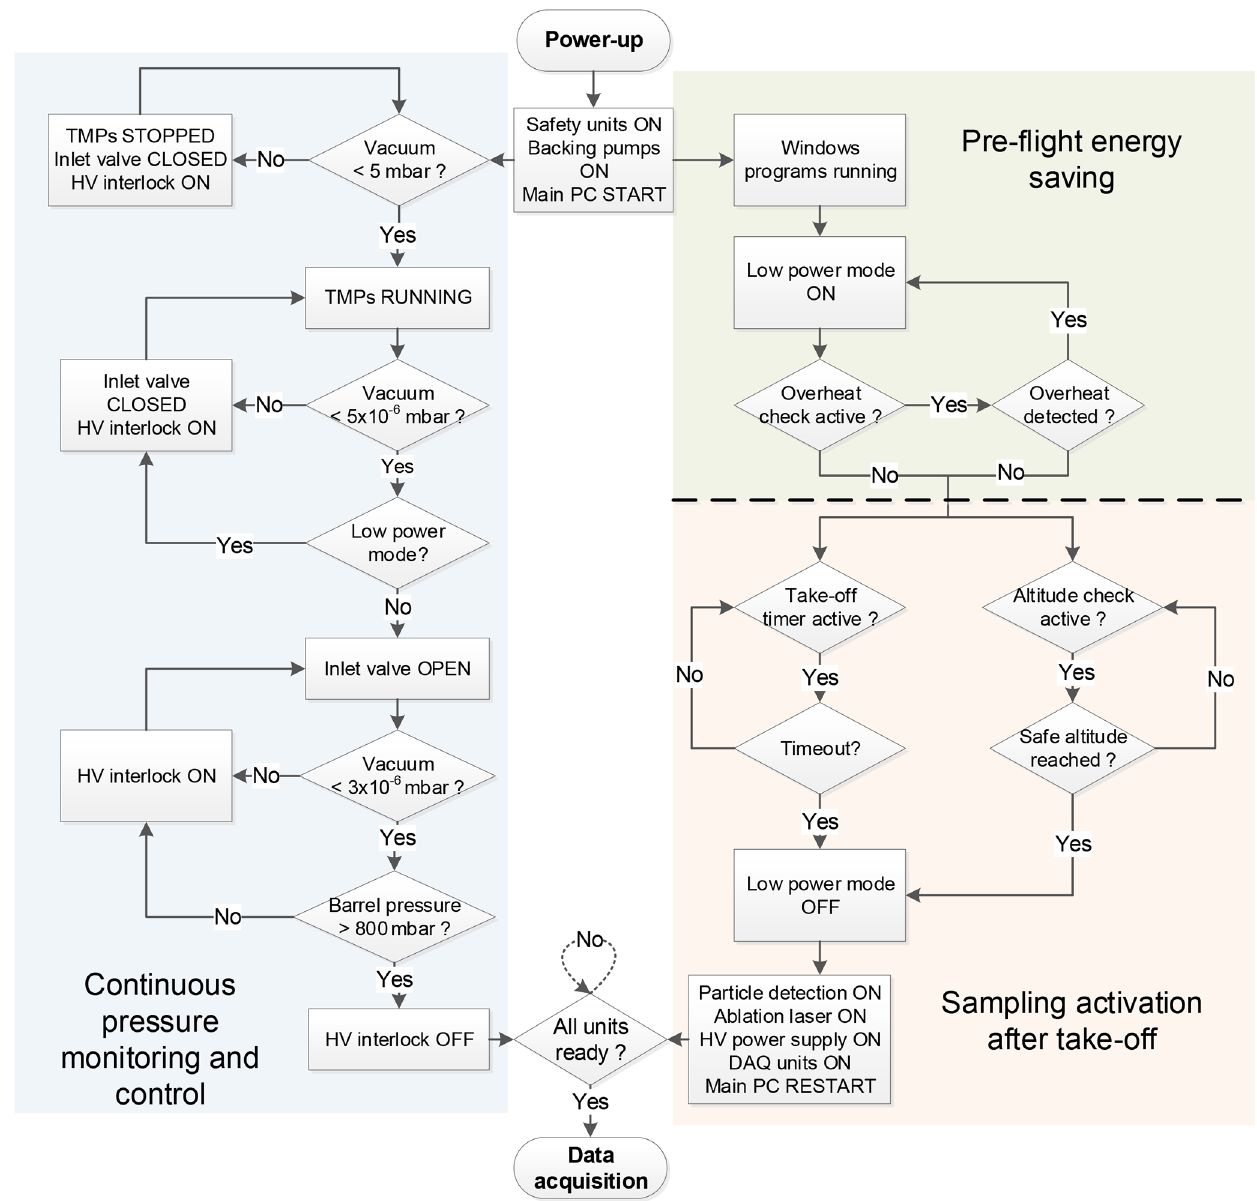
Figure 5. Flow chart of the automation of the main tasks performed by the ERICA during